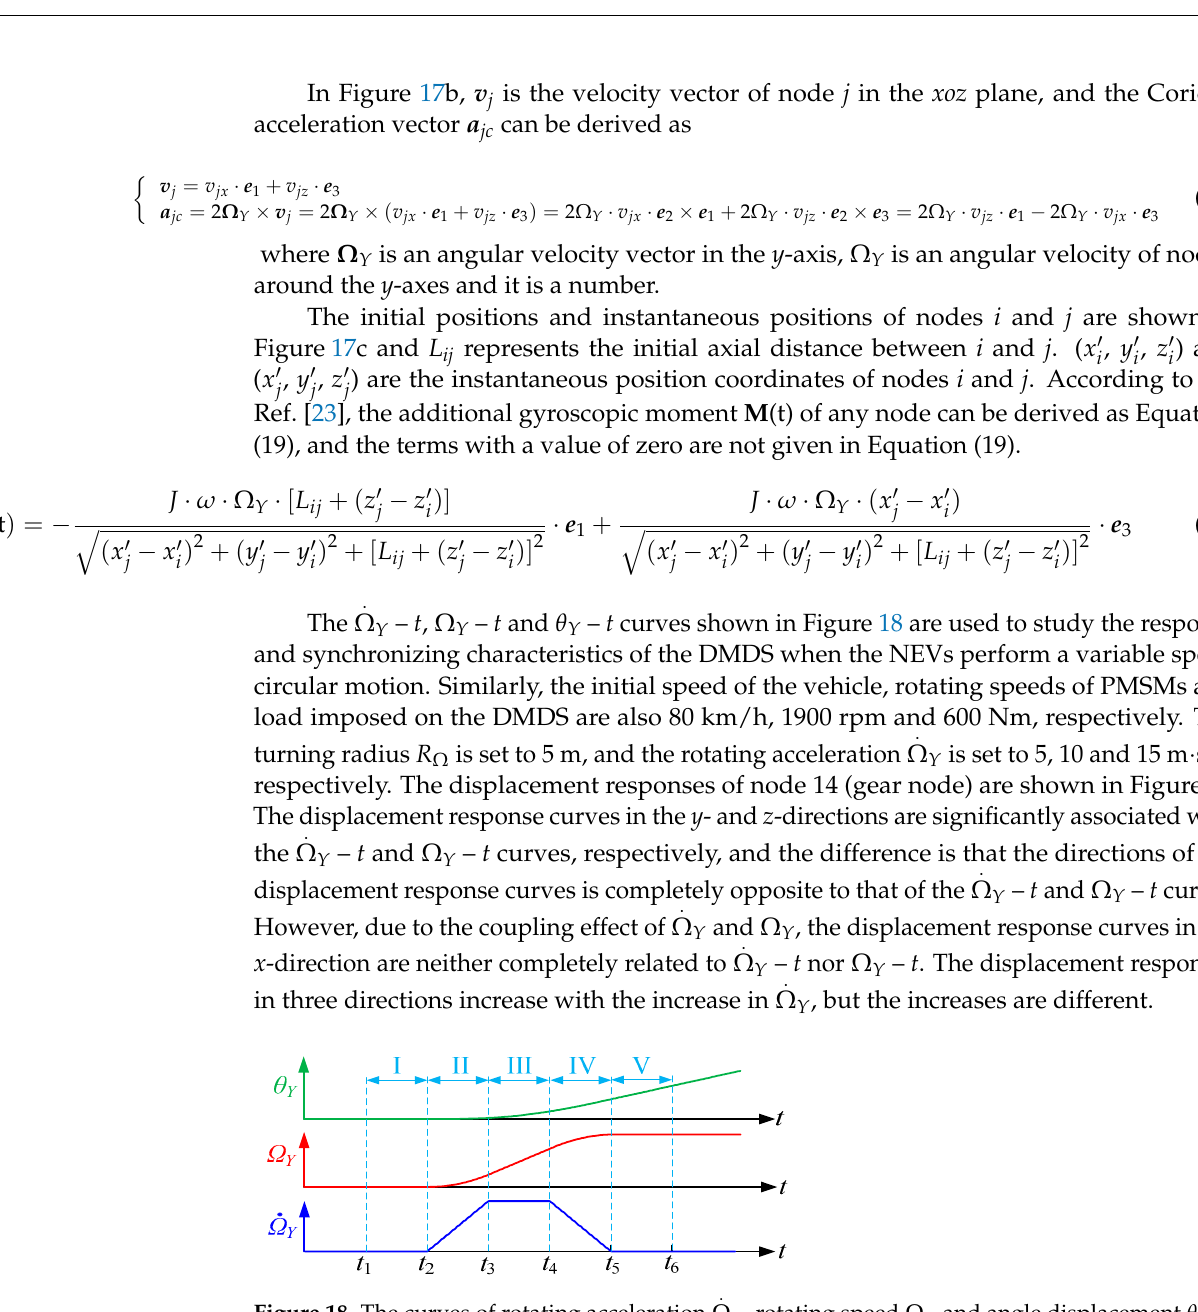
Figure 18. The curves of rotating acceleration Ω (cid:4662) Y , rotating speed Ω Y and angle displacement θ Y in variable-speed circular motion.